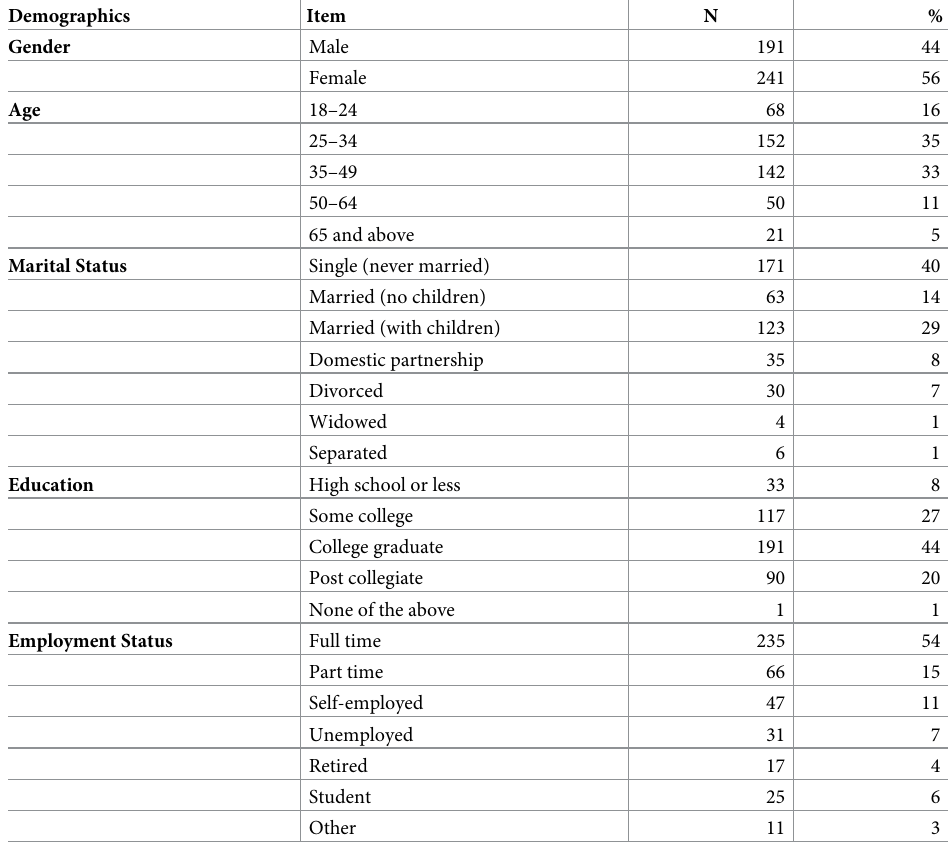
Table 1. Demographic profile of the sample (N =